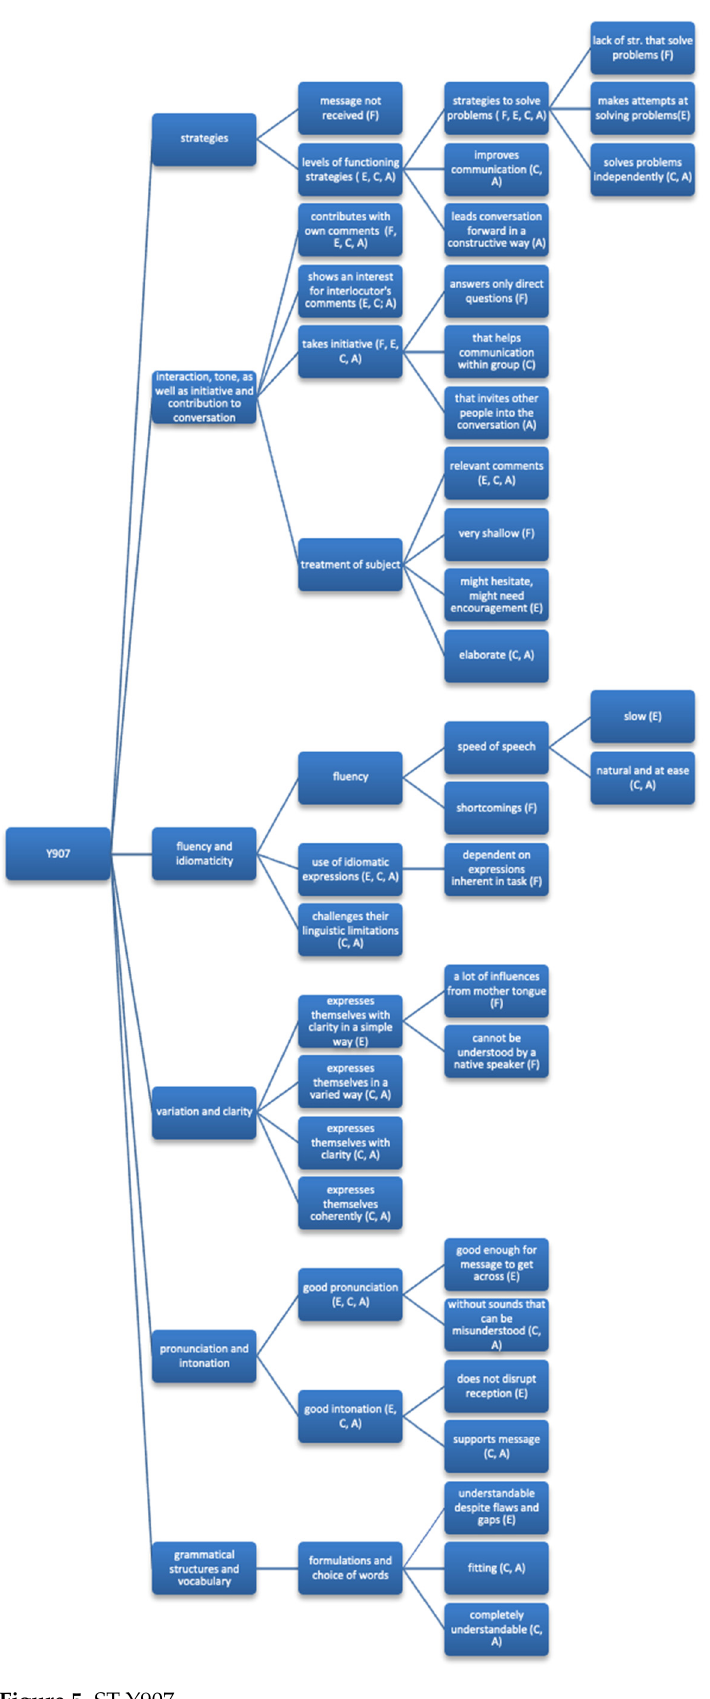
Figure 5. ST Y907.